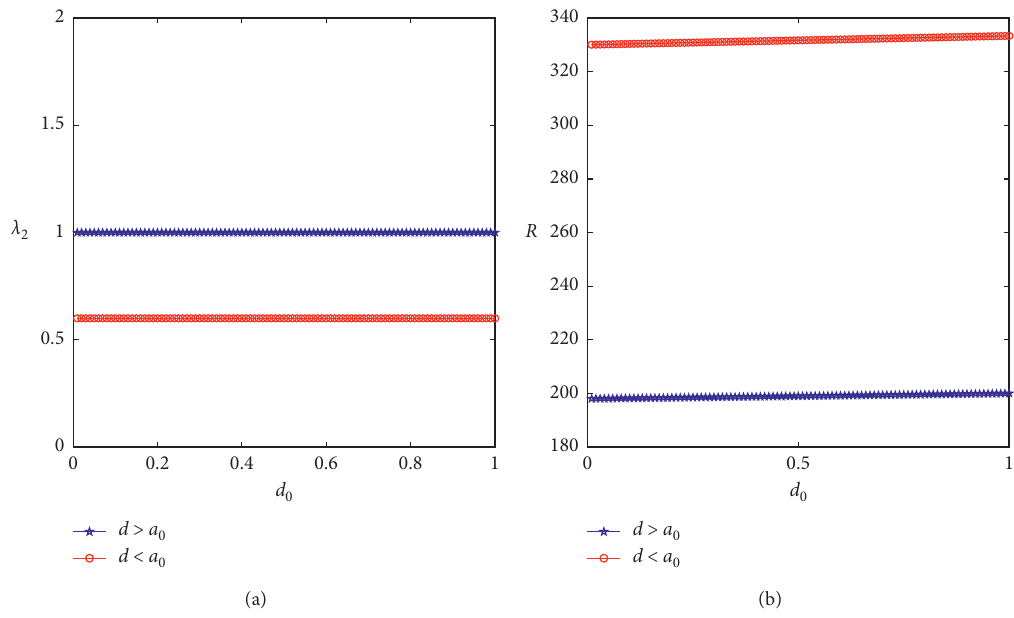
Figure 14: When N is odd, the synchronizability of Network II varies with the interlayer coupling strength d changes with d ( d changes from 0.01 to 1); (b) R changes with d 0 0